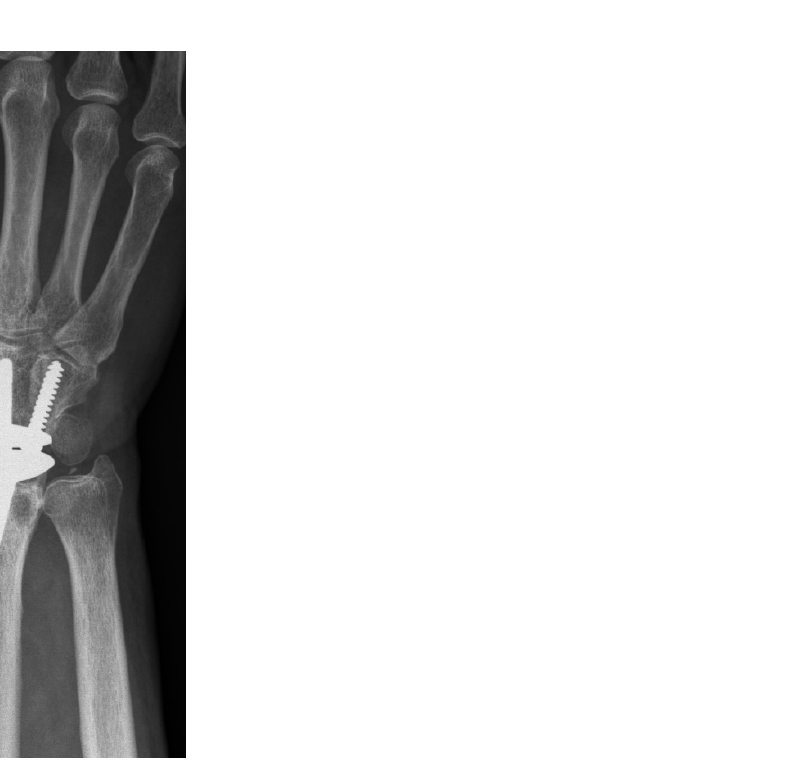
Figure 4. Kaplan–Meier Plot displaying cumulative revision-free survival functions. 4. Discussion Among non-rheumatoid patients treated with ReMotion TWA, we found that the PRC implantation technique could significantly reduce the clinical complication rate com- pared to the CCR method. Hence, the odds of suffering from any complication were 80% lower if the distal pole of the scaphoid was removed (i.e., total scaphoidectomy). This finding can largely be explained by the significant reduction of the radial impaction syn- drome’s occurrence to zero in the PRC cohort. Thus, we were able to verify the hypothesis of the present study.